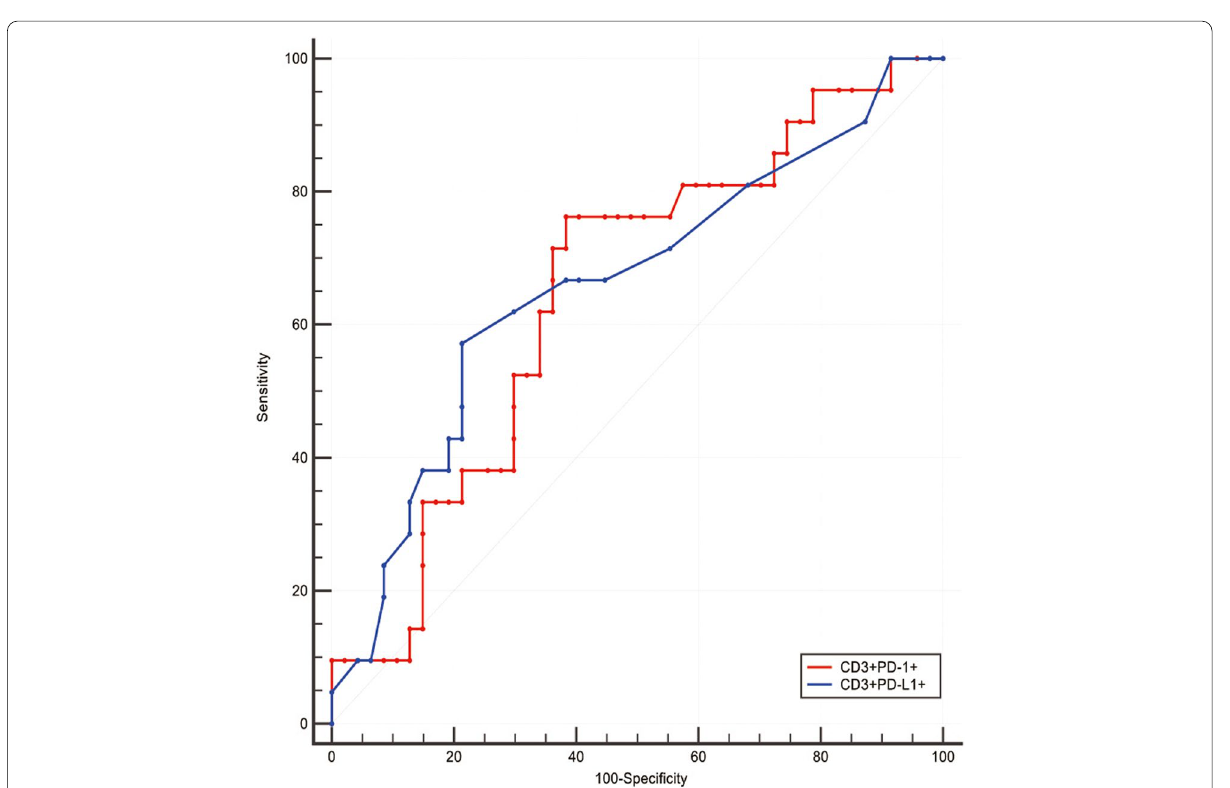
Fig. 3 ROC curve of peripheral PD-1/PD-L1 expression and TME PD-L1